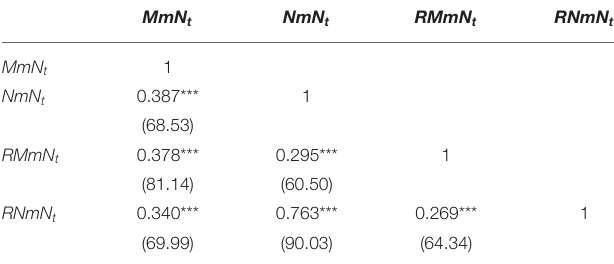
TABLE 8 | The mutual information matrix for the four types of main-media news.